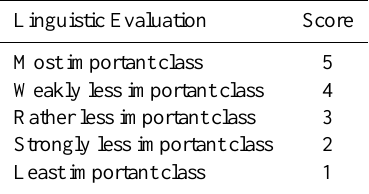
Table 7. Linguistic evaluations supporting the expert/decision maker in the assignation of weights to vulnerability factors and vul- nerability